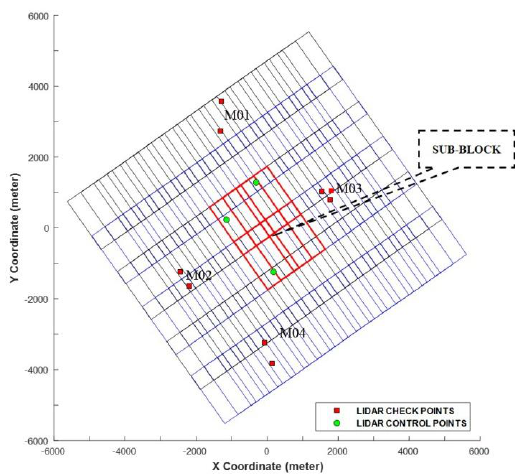
Figure 1. Layouts of the entire image block and the sub-block (red lines) and spatial distribution of twelve LCPs.